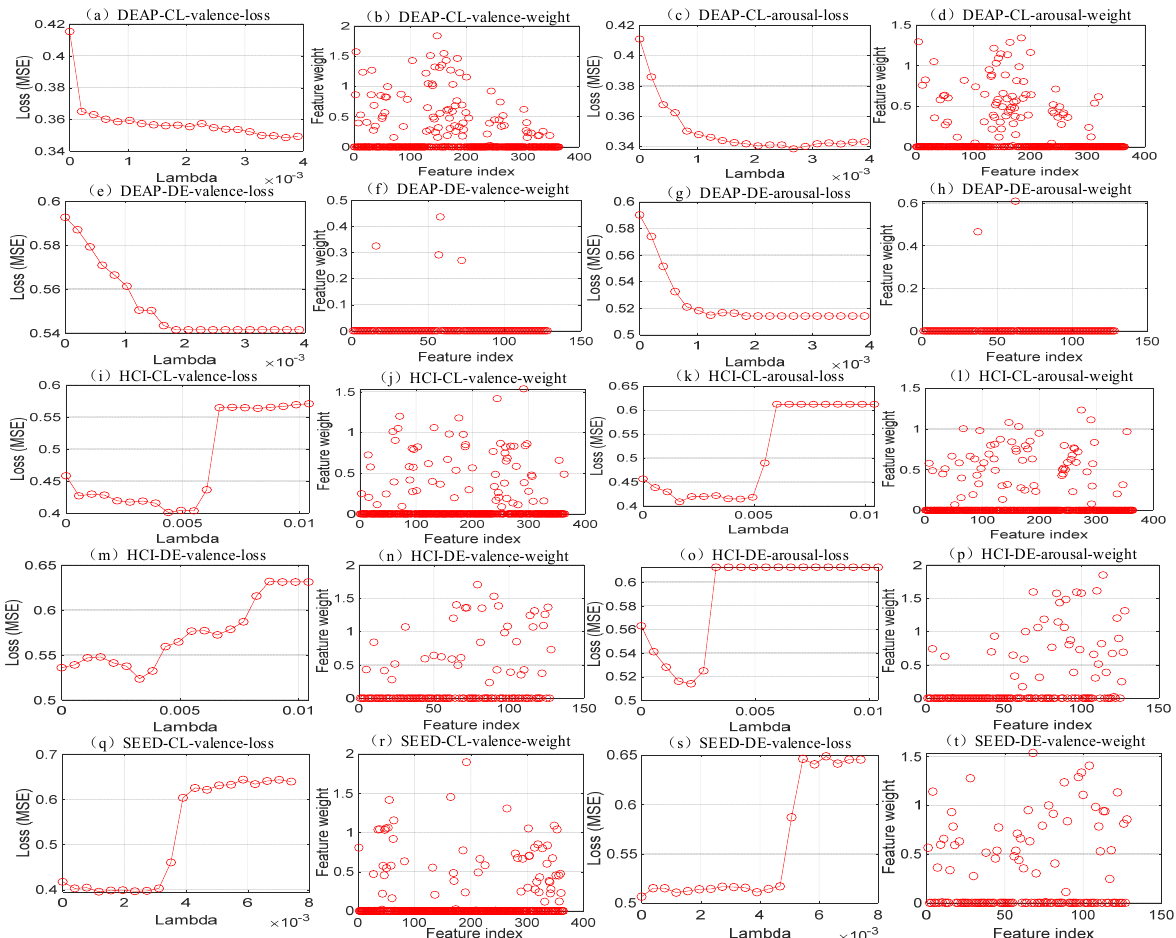
Figure 3. Model selection of the NCA. Subfigures ( a , b ) denote the loss values and the NCA weight for the CL features from the DEAP database of the valence dimension. Subfigures ( c , d ) denote the loss and NCA weight for the CL features from the DEAP of the arousal dimension. Subfigures ( e , f ) denote the loss and NCA weight for the DE features from the DEAP of the valence dimension. Subfigures ( g , h ) denote the loss and NCA weight for the DE features from the DEAP database of the arousal dimension. Subfigures ( i , j ) denote the loss and NCA weight for the CL features from the MAHNOB-HCI database of the valence dimension. Subfigures ( k , l ) denote the loss and NCA weight for the CL features from the MAHNOB-HCI of the arousal dimension. Subfigures ( m , n ) denote the loss and NCA weight for the DE features from the MAHNOB-HCI of the valence dimension. Subfigures ( o , p ) denote the loss and NCA weight for the DE features from the MAHNOB-HCI of the arousal dimension. Subfigures ( q , r ) denote the loss and NCA weight for the CL features from the SEED database of the valence dimension. Subfigures ( s , t ) denote the loss and NCA weight for the DE features from the SEED of the valence dimension.